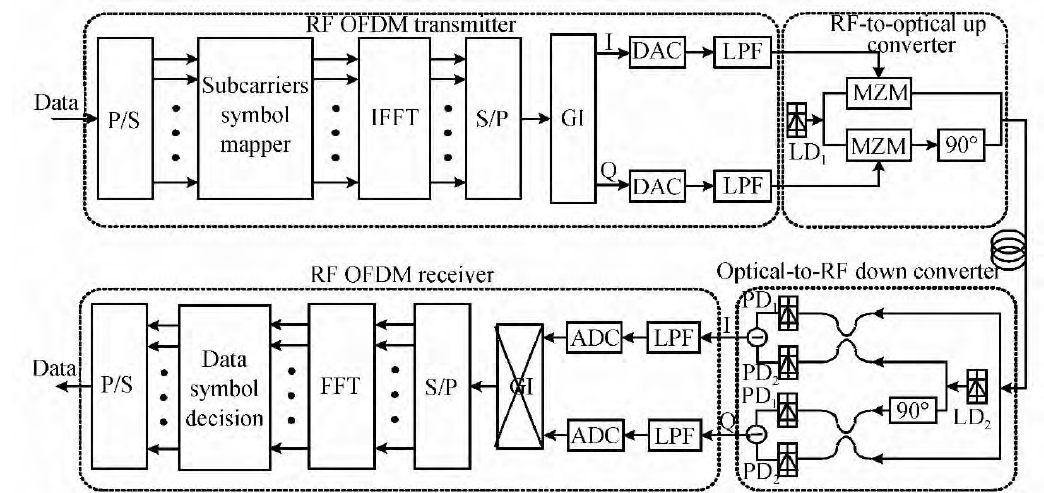
Fig. 1 CO-OFDM system block diagram. FFT, fast Fourier transform.